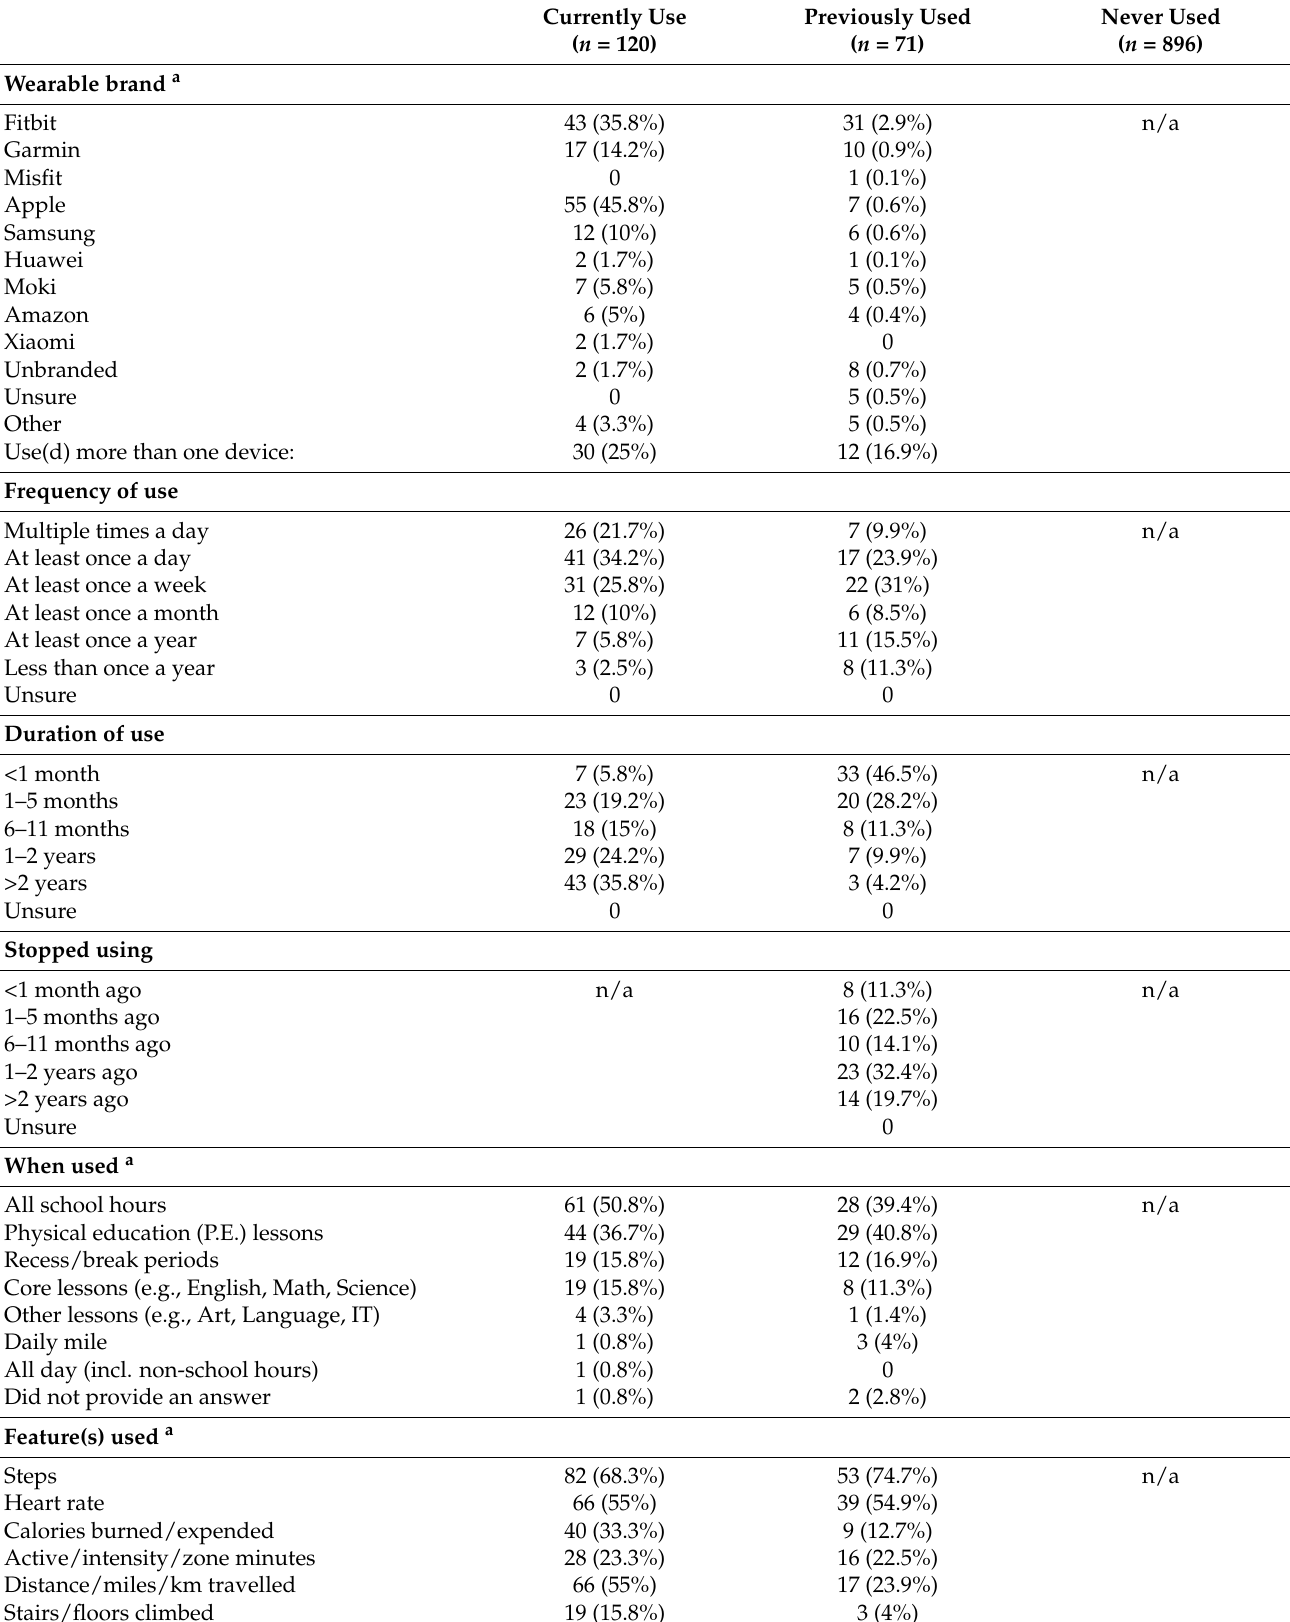
Table 2. School staff’s use of wearables as teaching or support tools in school, n